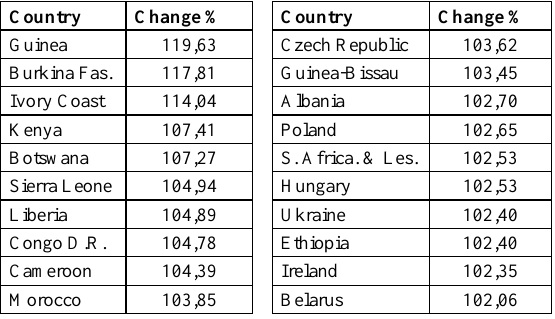
Table 1. Change of OSM data size for selected African & European countries, observed between 10 Nov. 2014 - 6